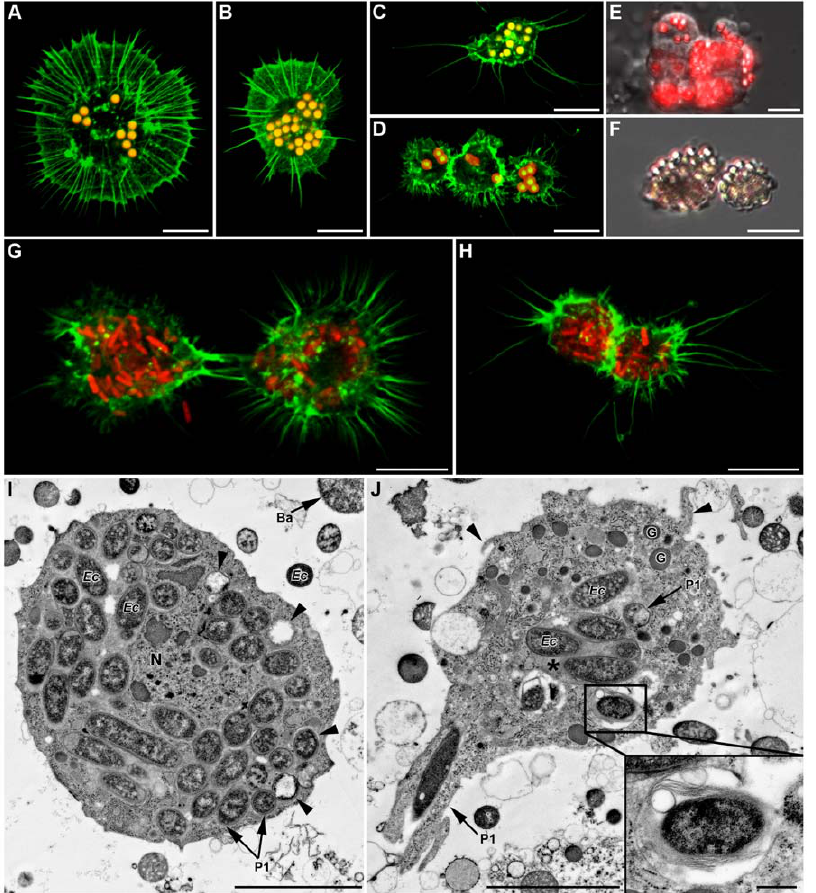
Figure 7. Invivo phagocytosis of fluorescent latex beads and fluorescent E.coli 24 h post-injection in LL01 aphids. (A–D) Confocal images of both granulocytes (A and B) and plasmatocytes (C and D) having ingested numerous latex beads (yellow-red fluorescence). (E) Merger of DIC and fluorescent micrographs showing an aggregate of hemocytes actively phagocytizing beads (red fluorescence). (F) Melanization of ingested latex beads (brown staining). (G–H) Granulocytes (in G) and plasmatocytes (in H) containing numerous red fluorescent bacteria (F-actin in green); Scale bar: 10 m m (A–H). (I–J) TEM micrographs showing uptake and degradation of ingested bacteria. (I) E. coli bacteria inside the cytoplasm of a granulocyte (arrowheads: bacteria at different degrees of degradation). (J) Granulocyte phagocytizing a bacterium in a zipper-like manner ( P1